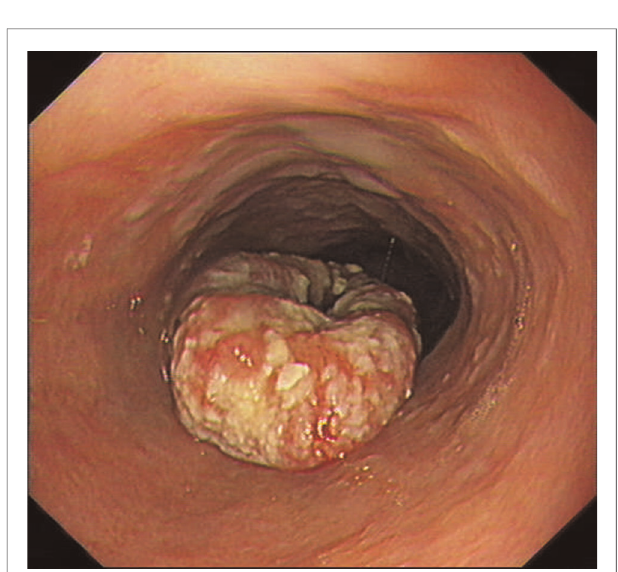
FIGURE 3 | Gastric endoscopy showed the lower part of the esophagus.